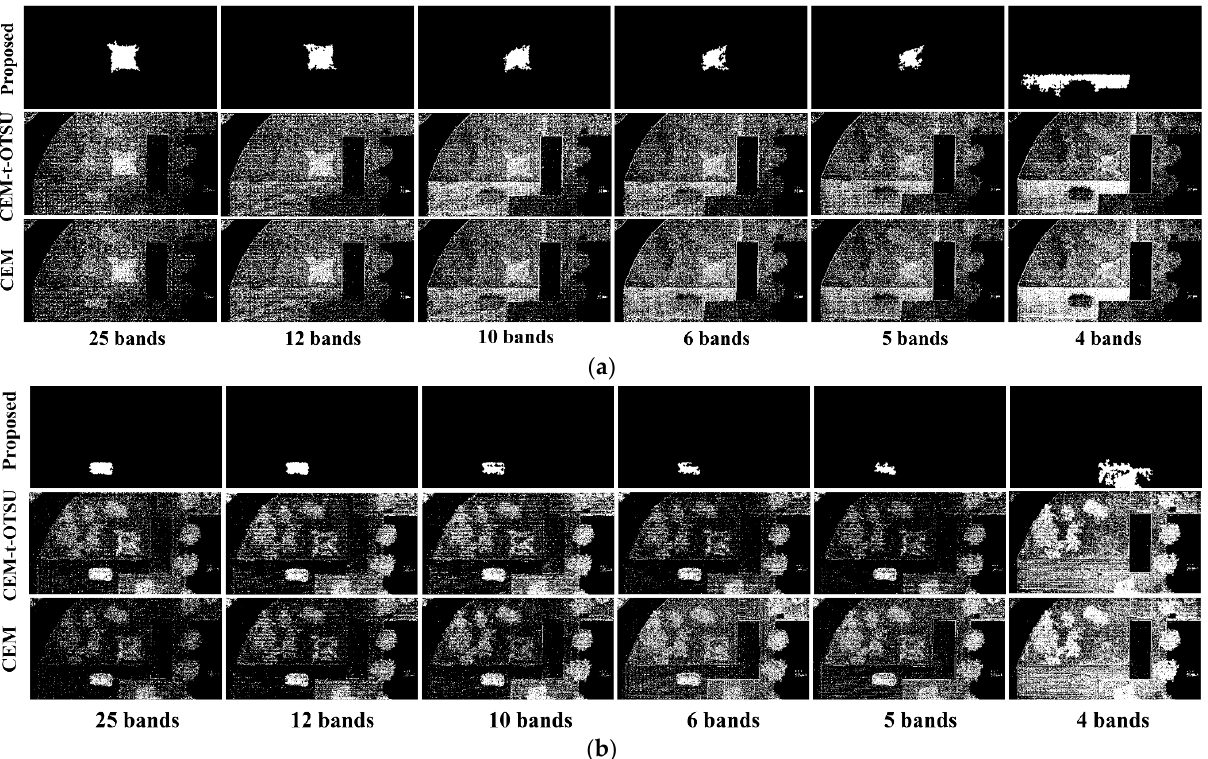
Figure 21. The detection results of two targets in the UAV scene with bands ranging from four to 25. ( a ) The results of camouflaged tent detection with different algorithms. ( b ) The results of camouflaged vehicle detection with different algorithms. All results are normalized to [0,1] for a fair comparison.